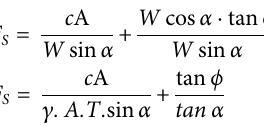
Frontiers in Earth Science |